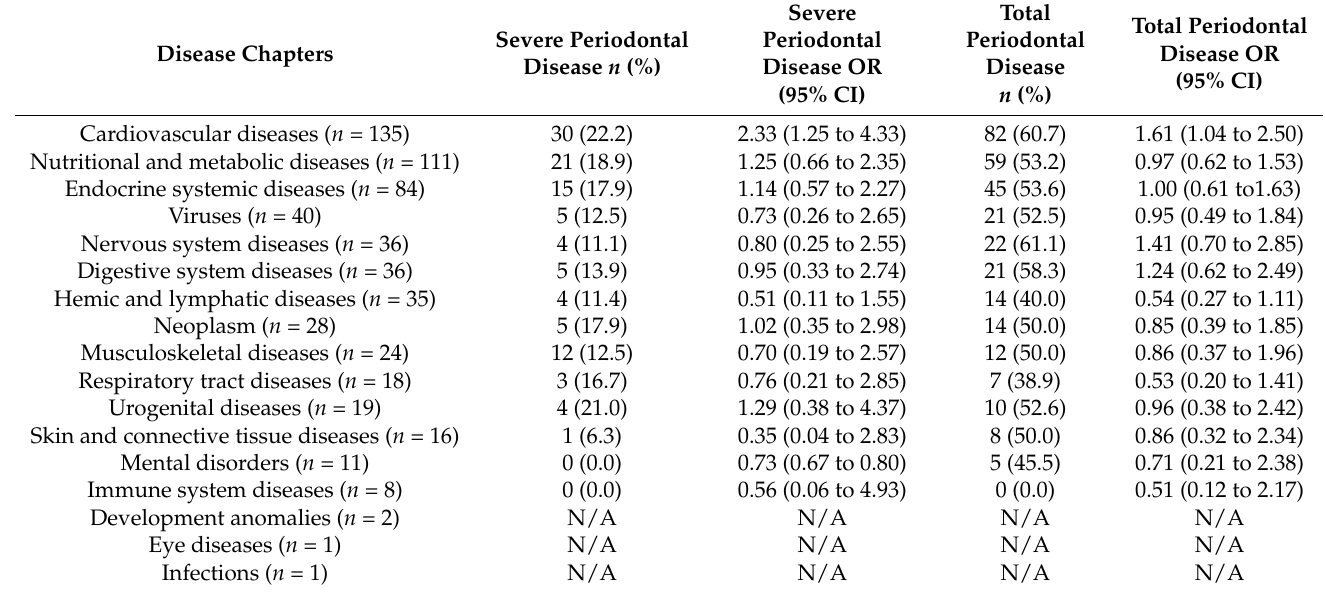
Table 4. Prevalence of each disease chapter and its associations with the periodontal